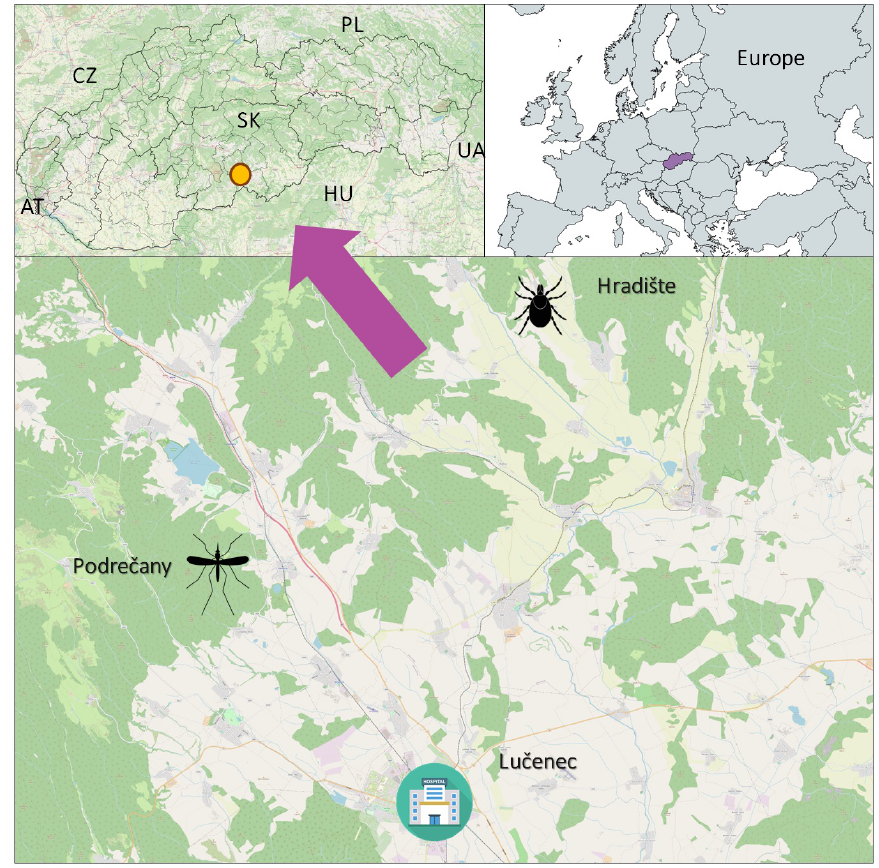
Viruses 2023 , 15 , x FOR PEER REVIEW Figure 1. The area of co-circulation of West Nile (WNV), Usutu (USUV), and tick-borne encephalitis (TBEV) viruses in Slovakia, Central Europe. Legend: mosquito icon—WNV, USUV focus, tick icon— TBEV focus, hospital icon—the catchment hospital, orange dot—placement of the area in Slovakia, AT—Austria, CZ—Czechia, HU—Hungary, PL—Poland, SK—Slovakia, UA—Ukraine.